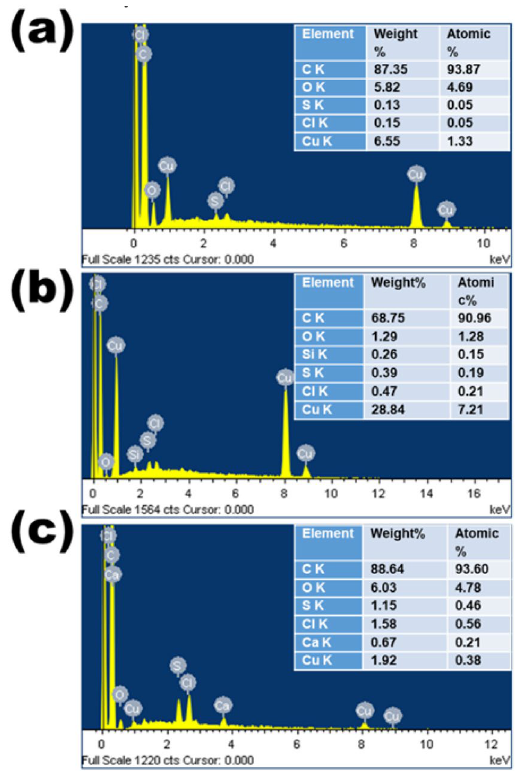
Figure 2. EDS spectra of CNS prepared at 650 °C from nettle stems ( a ) and leaves ( b , c ) using NaHCO 3 as an activating agent. The ratio of nettle powder and NaHCO 3 is 1:1 ( a , b ) and 1:2 ( c ).